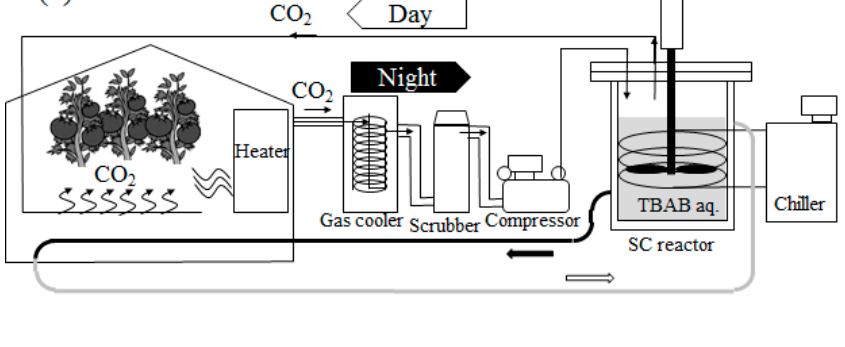
7 of 11 Figure 5. Conceptual diagram of semi-clathrate hydrate cycle. During the day, the temperature controller ceases operation and the temperature of the reactor warms to the ambient temperature above the equilibrium point of SC hydrate, and CO 2 + N 2 gas automatically emerges for CO 2 enrichment. At the same time, because the SC dissociation is an endothermic reaction, cold heat may be obtained and used to cool parts of the greenhouse. After completion of TBAB SC dissociation, reactor conditions are reset to the initial state. 4.2. Configuration of CO 2 Enrichment System Using TBAB + CO 2 SC